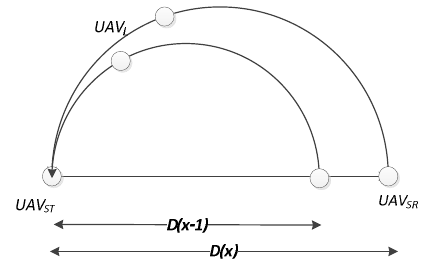
Figure 5. The illustration of dynamic mobility of suspicious UAVs.